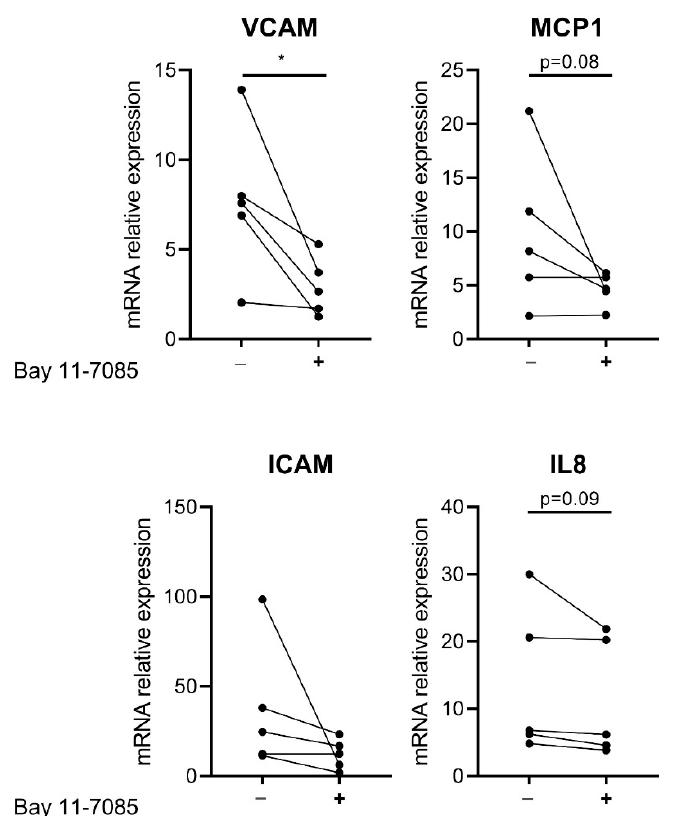
Figure 4. Effect of NF- κ B inhibition on CTEPH-ECs . Cultured CTEPH-ECs were incubated with the NF- κ B inhibitor Bay 11-7085 at a final concentration of 1 µ M. mRNA levels of VCAM-1 were significantly reduced in CTEPH-ECs after treatment with Bay 11-7085. mRNA levels of ICAM-1 and MCP-1 showed a trend towards reduction after Bay 11-7085 incubation. IL-8 mRNA expression levels were found to be similar between the CTEPH-ECs incubated with Bay 11-7085 and those without. CTEPH-ECs, n = 5 donors; unpaired t-test, p < 0.05 = *, data are expressed as mean ± SD.